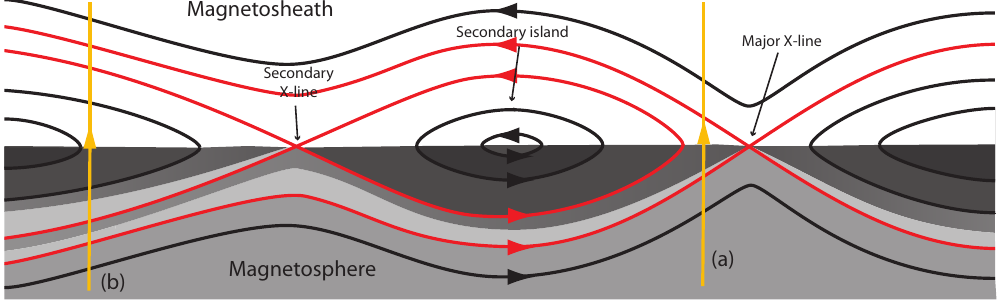
Fig. 10. Illustration of the spacecraft crossings of the magnetopause during reconnection due to multiple X-lines. The major X-line is on the right and the secondary X-line is on the left. Separatrices associated with the X-lines are marked in red and plasma density is shaded in grey, density cavities associated with the X-lines can be seen as light grey bands next to the separatrices. Two example crossings by spacecraft are marked in yellow. The spacecraft on the left crosses a wide cavity with multiple dips due to multiple X-lines, the spacecraft on the right crosses closer to the major X-line and sees only one narrow